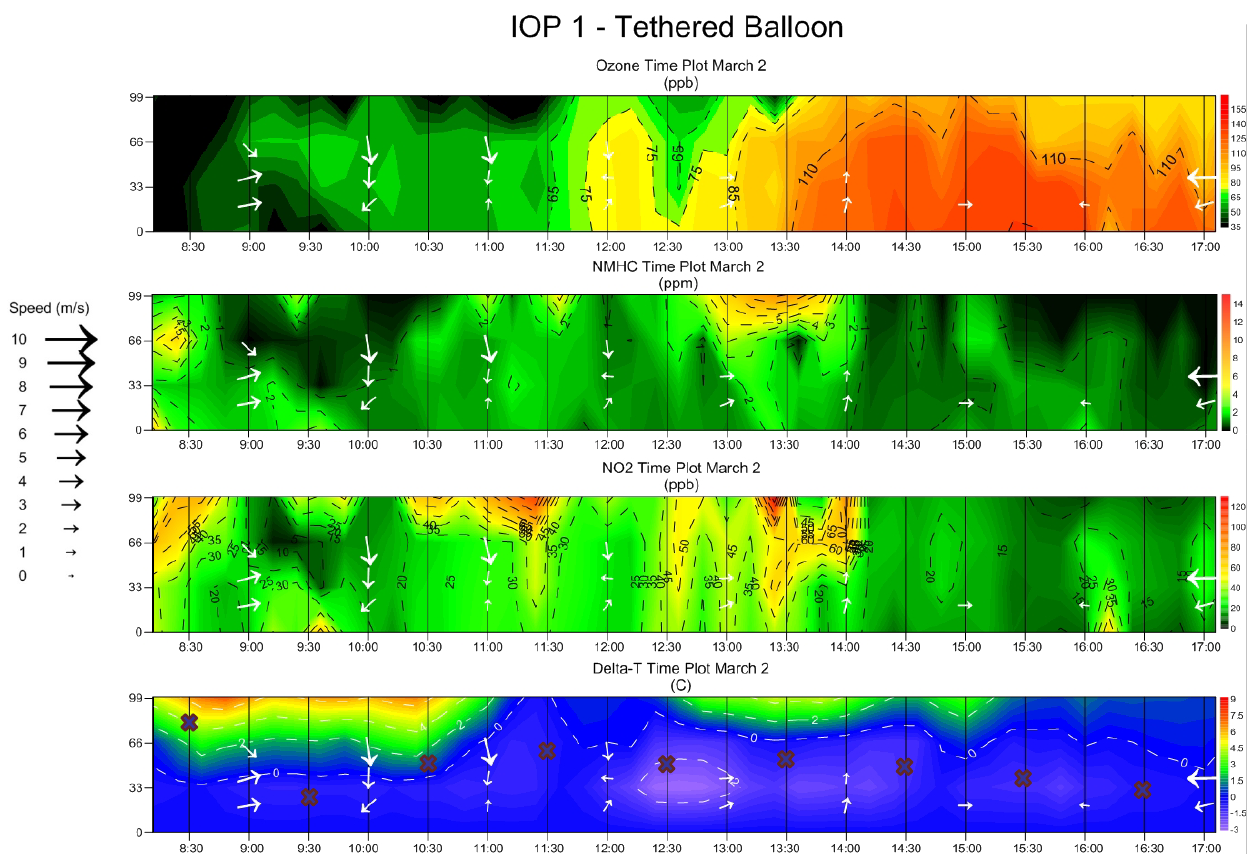
Figure 7. Results from tethersonde measurements of ozone, NMHC, NO 2 , and 1T (Delta-T) on 2 March 2011. 1T is defined as the temperature at a given level minus the temperature at the surface. Mixing layer heights as determined by SODAR data are indicated as “x” in the 1T